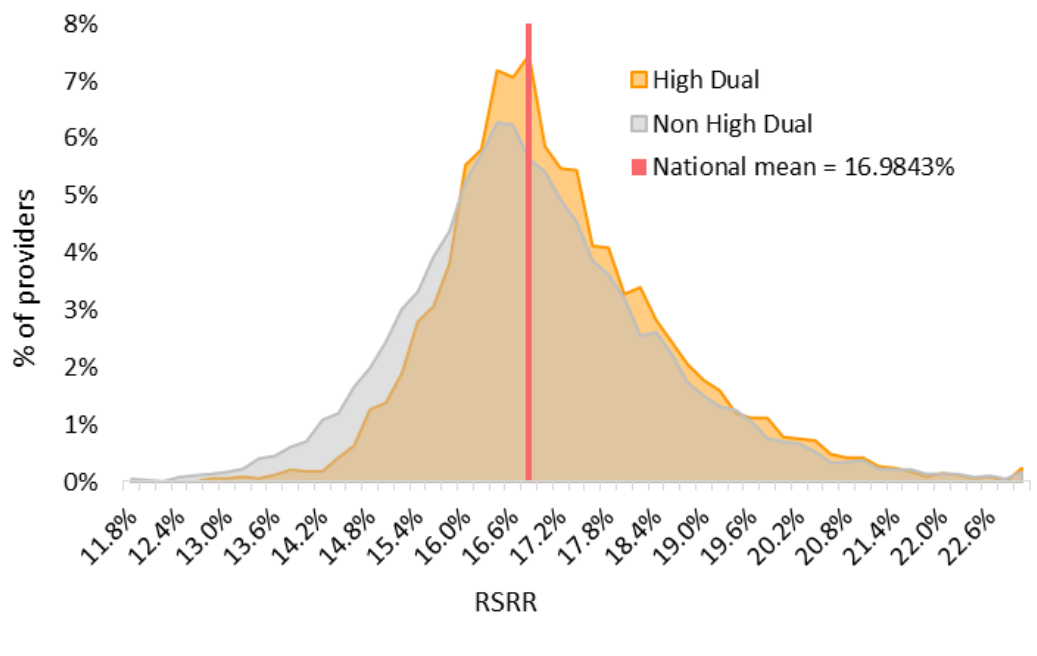
Figure 4.1: Distribution of Risk-Standardized Readmission Rates (RSRR) for High-Dually-enrolled versus Non-High-Dually-enrolled